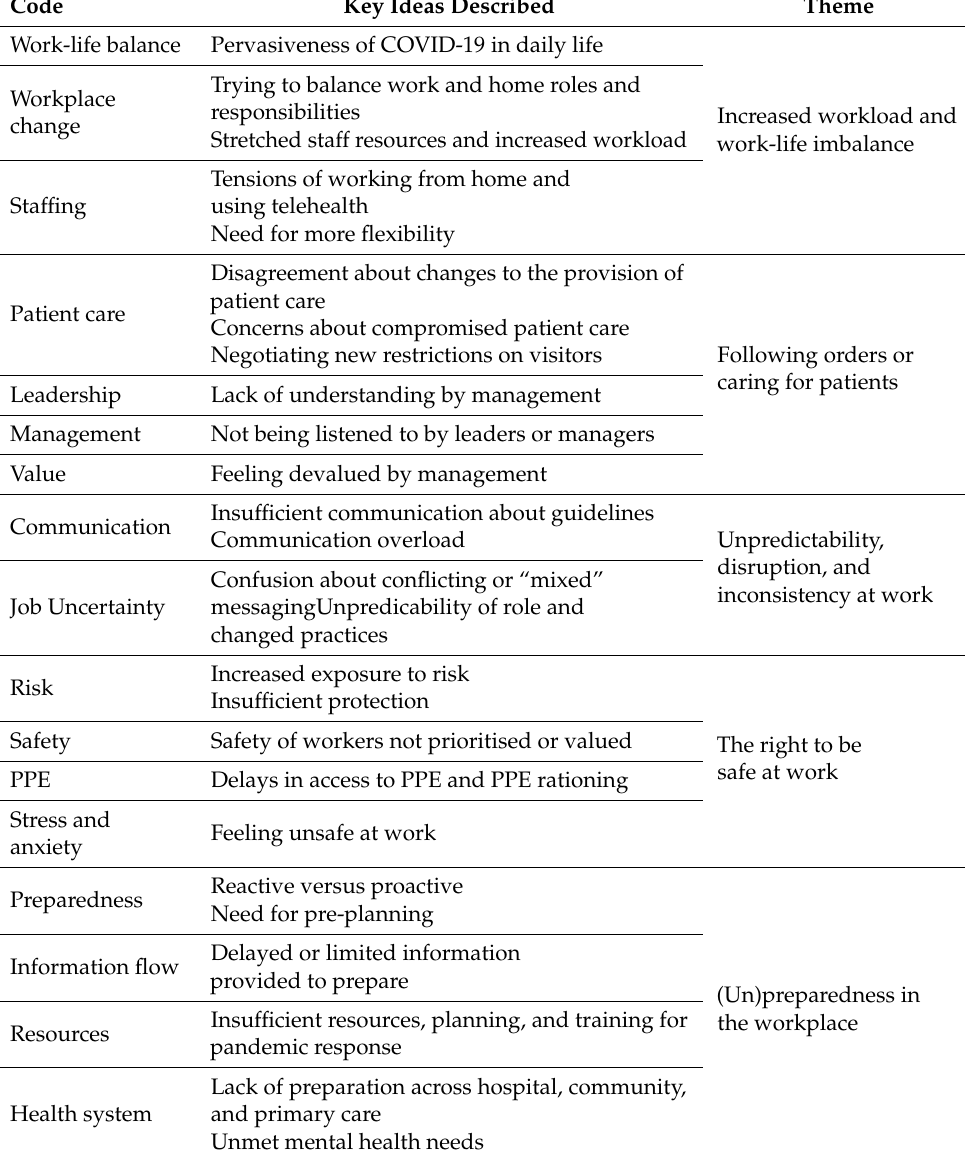
Table 2. From codes to key ideas to